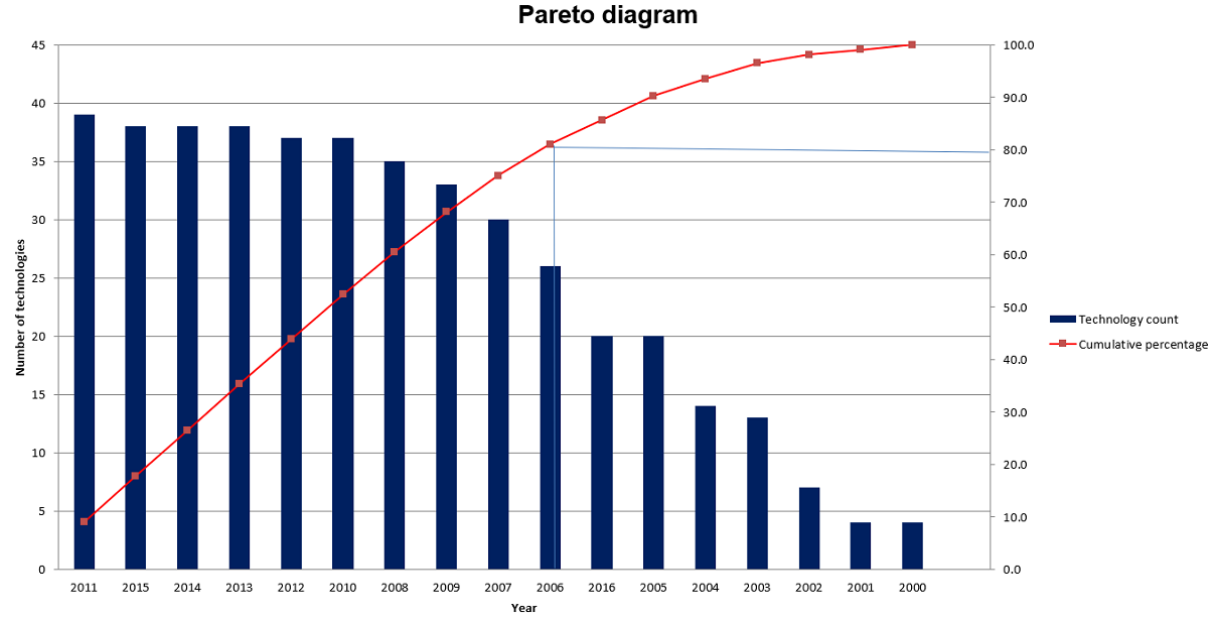
Figure 4. Pareto analysis diagram in uncontrolled